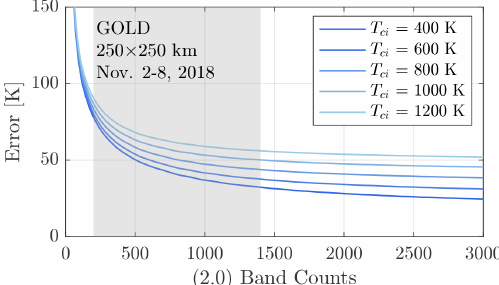
Figure 5. Pressure at the peak of the LBH contribution function, p τ = 1 , as a function of SZA and OZA determined from forward modeling WAM simulations for the period of 2–8 November 2018 considering realistic forcing conditions. LBH emissions are on con- stant pressure level surfaces given SZA and OZA. Approximate cor- responding altitudes in the WAM simulations are also provided, but note that these altitudes will vary depending on the forcing condi- tions.